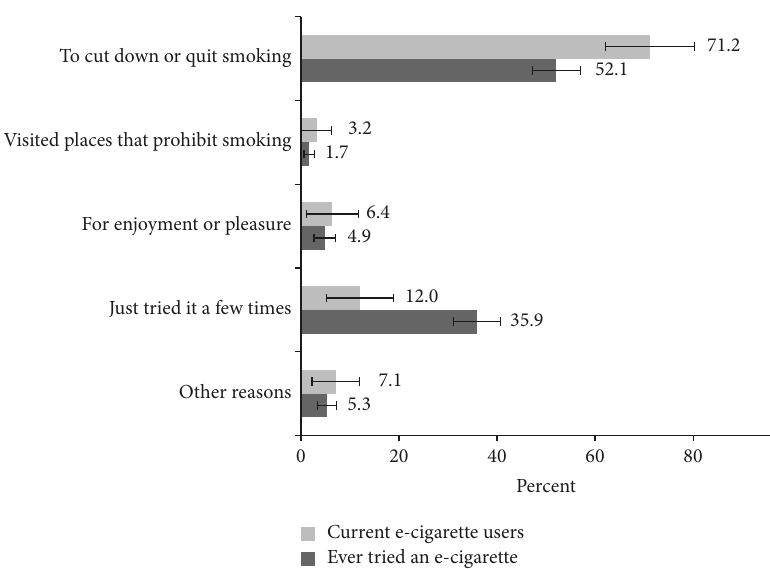
Figure 1: Reasons for trying or using e-cigarettes among Mississippi adults who have ever tried e-cigarettes and current e-cigarette users, Behavioral Risk Factor Surveillance System,